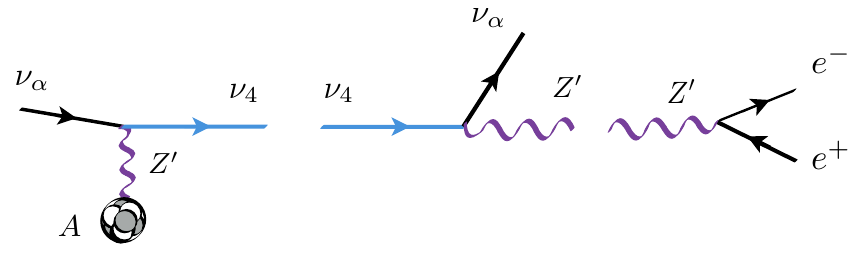
Figure 9.1: Diagram of production of MiniBooNE signature. A heavy neutrino, ν is produced via the exchange of a dark photon with the nucleous. For the realization < m in [ 200 ] , m and the decay chain follows as shown. In the scenario by [ 226 ] , Z (cid:48) 4 > m m and the decay chain shown is forbidden; instead once ν Z (cid:48) 4 three body decay into ν α e + e −